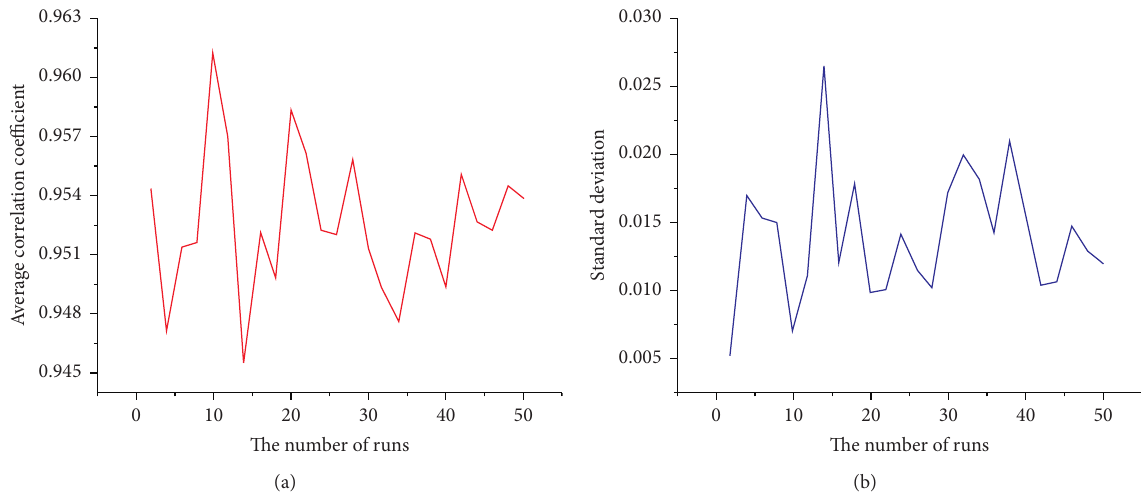
Figure 8: Influence of the number of runs on the average correlation coefficient and its standard deviation.